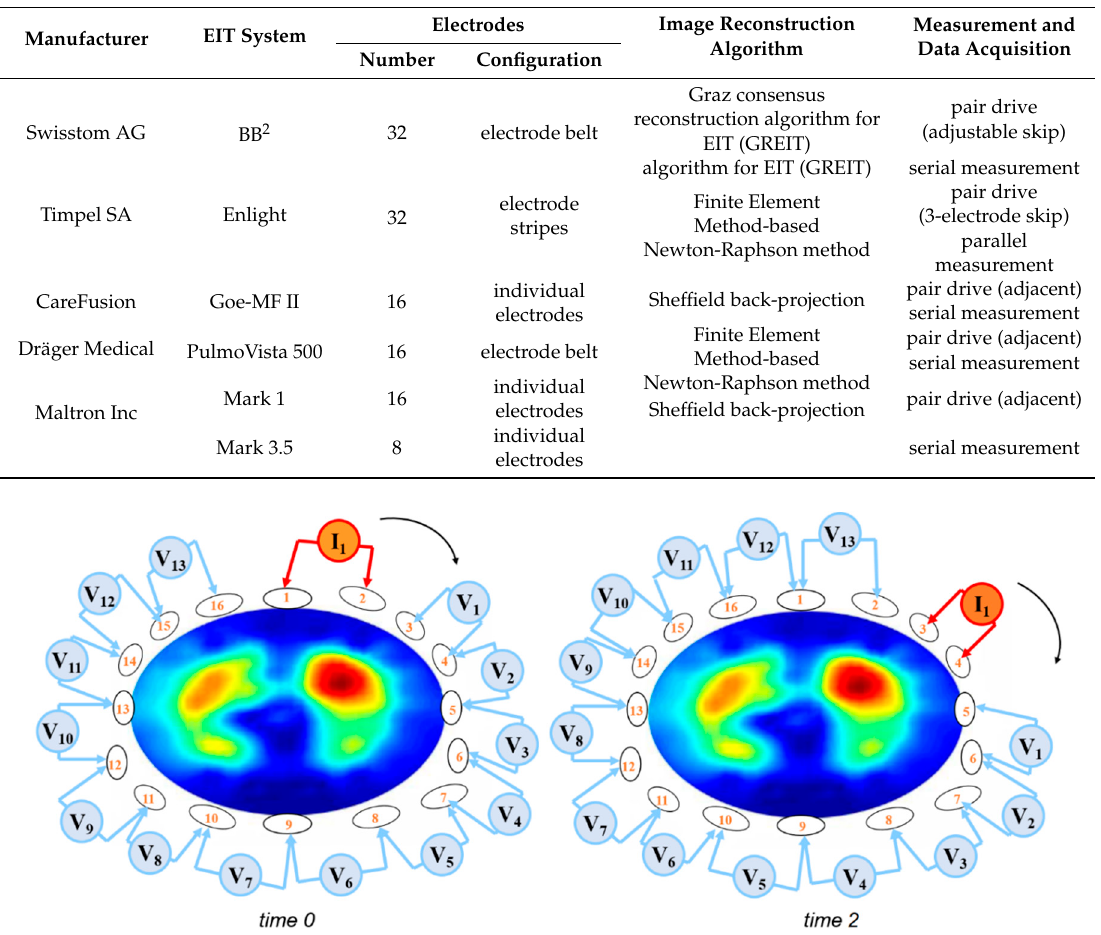
Table 2. Commercially available electrical impedance tomography (EIT) devices.